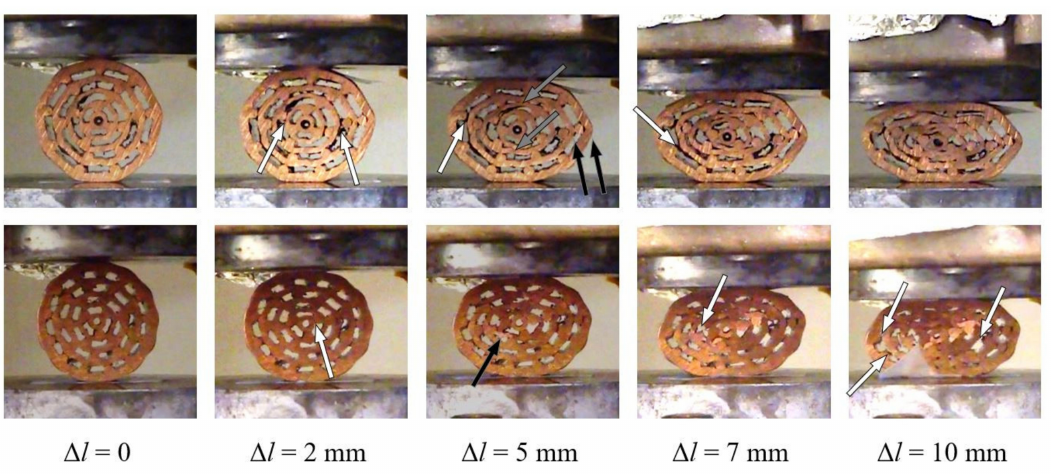
Figure 8. Deformation mechanism (white arrows denote debonding, black denote bending or buckling, and grey arrows denote contact) of the type 1 specimens (#1.1: upper row; #1.2: lower row). Uniform deformation throughout the loading process was observed for both